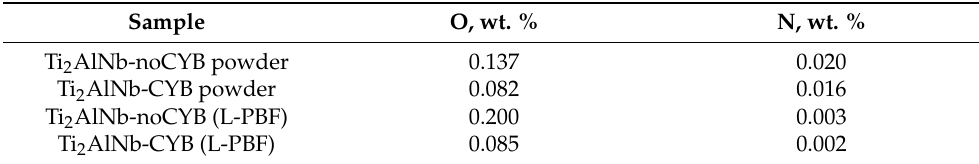
Table 3. Oxygen and nitrogen content in the initial powders and fabricated samples.